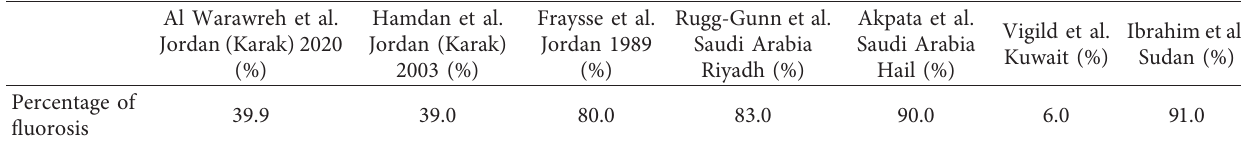
Figure 3: Incidence of fluorosis grouped by source of water in first 10 years after birth. Table 5: Incidence of fluorosis in the